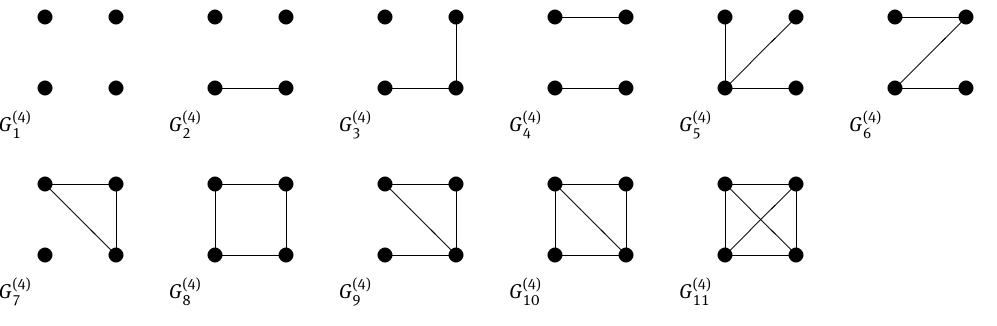
Figure 5.1: The graphs on four